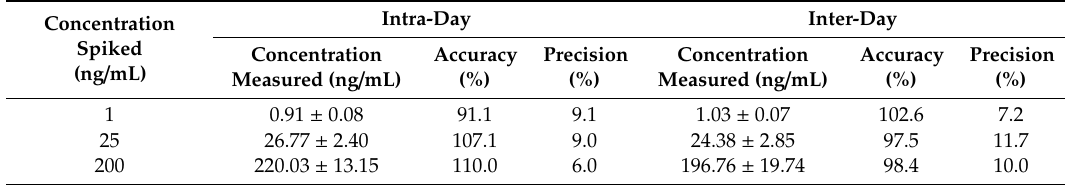
Table 2. Precision and accuracy of the assay of celastrol in rat plasma ( n = 6).